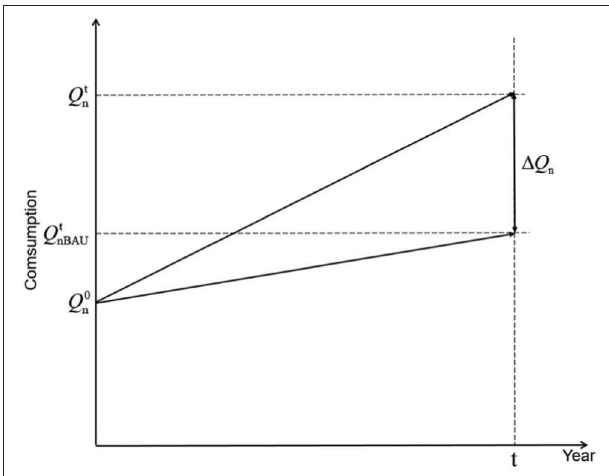
FIGURE 4 | Relationships among Q 0 n , Q t n , and Q t nBAU .